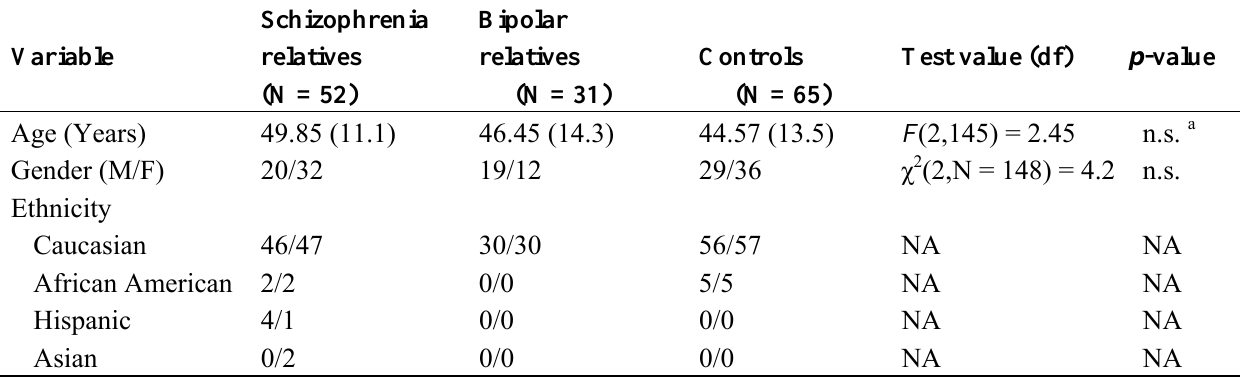
Table 2. Participant characteristics: demographic and clinical information for first-degree biological relatives of schizophrenia patients, first-degree biological relatives of bipolar patients and nonpsychiatric